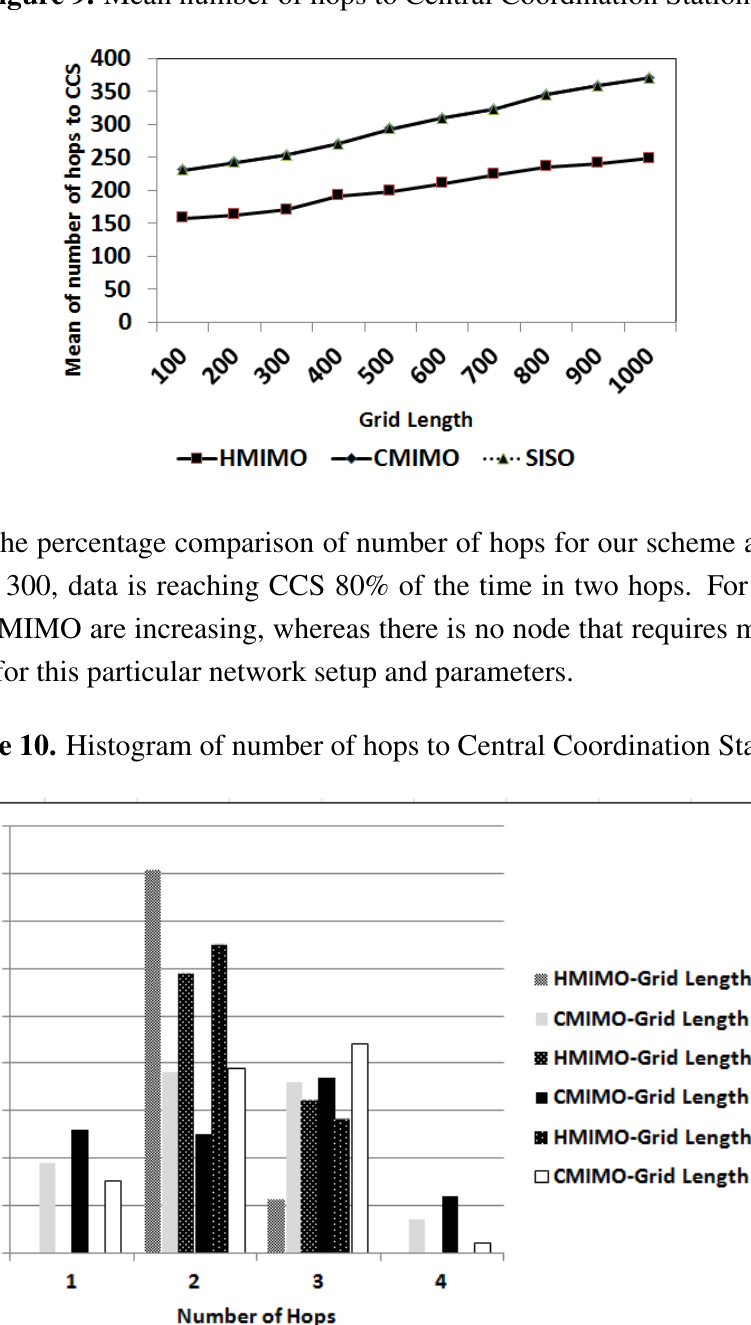
Figure 9. Mean number of hops to Central Coordination Station.